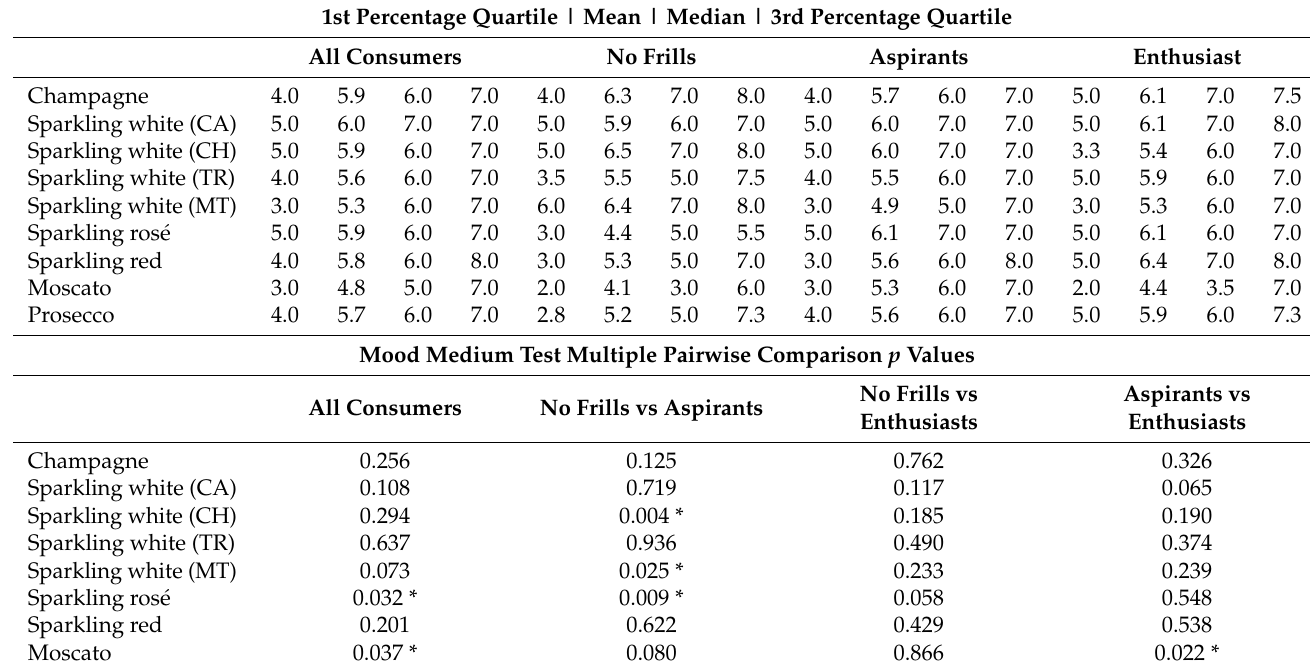
Table 5. Liking scores of consumers and Fine Wine Instrument consumer segments for the different sparkling